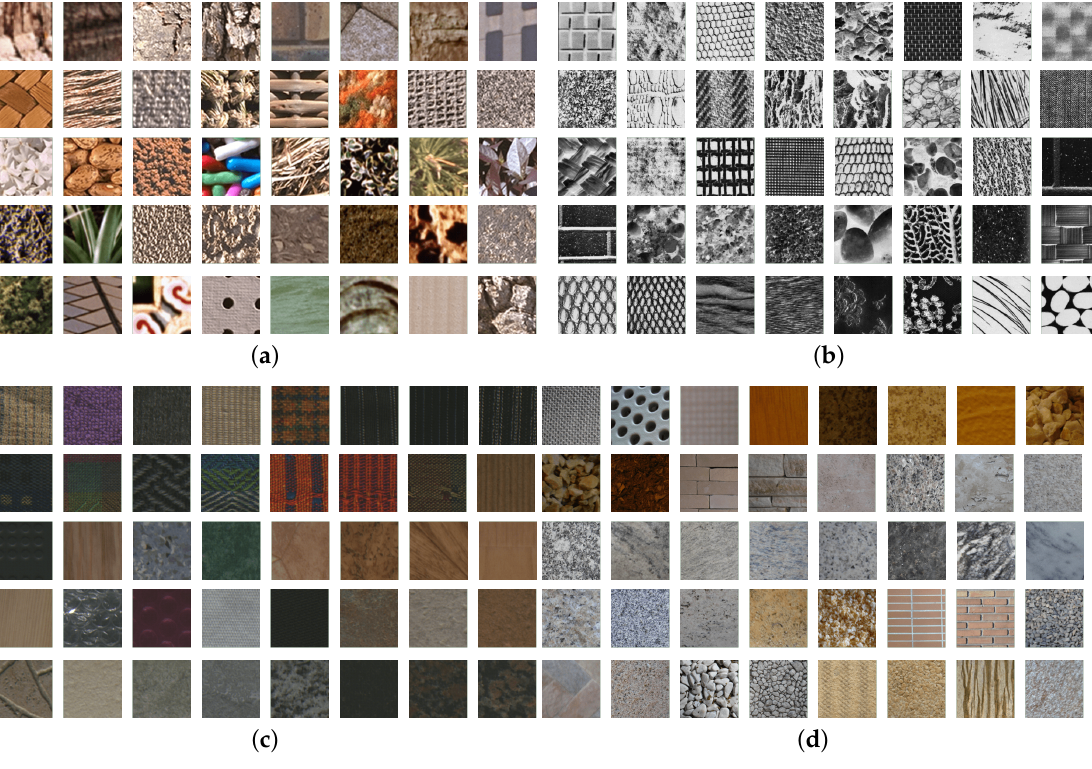
Figure 3. Examples of texture images used in the experimental study issued from the ( a ) VisTex, ( b ) Brodatz, ( c ) Outex and ( d ) USPtex texture databases. Table 2. Description of the texture databases used in this